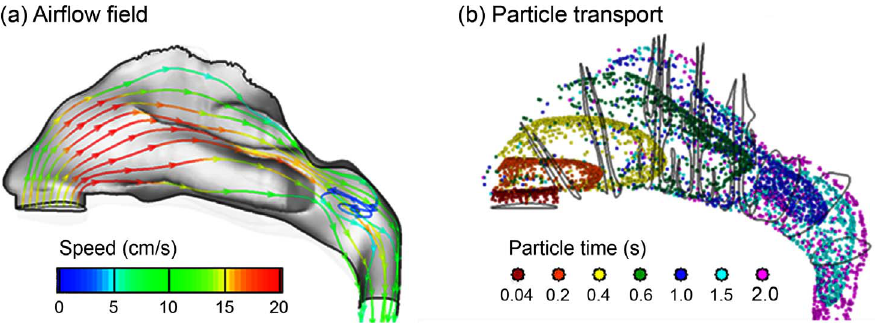
Figure 7. Inhalation airflow streamlines (a) and snapshots of particle transport (b) at different instants inside the nasal cavity.